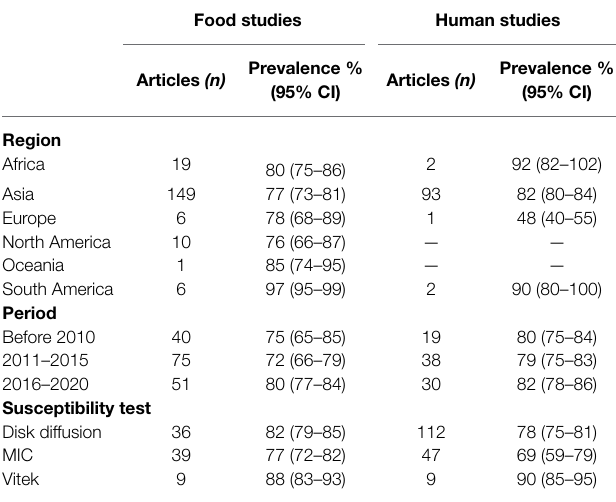
TABLE 5 | Subgroup analysis of antibiotic resistance by region, time period and susceptibility